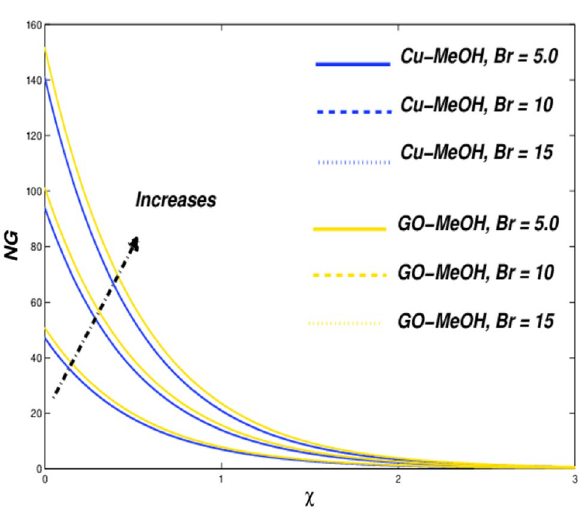
Figure 27. Entropy variation versus Br .